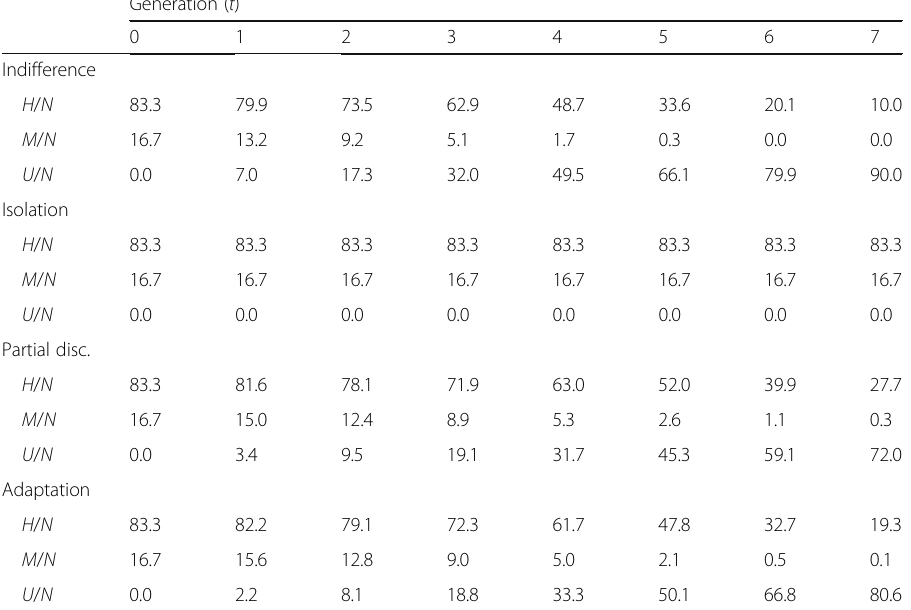
Table 3 Component populations as percent of total: four alternative preference patterns with one- time immigration ( ϕ = 0.20)